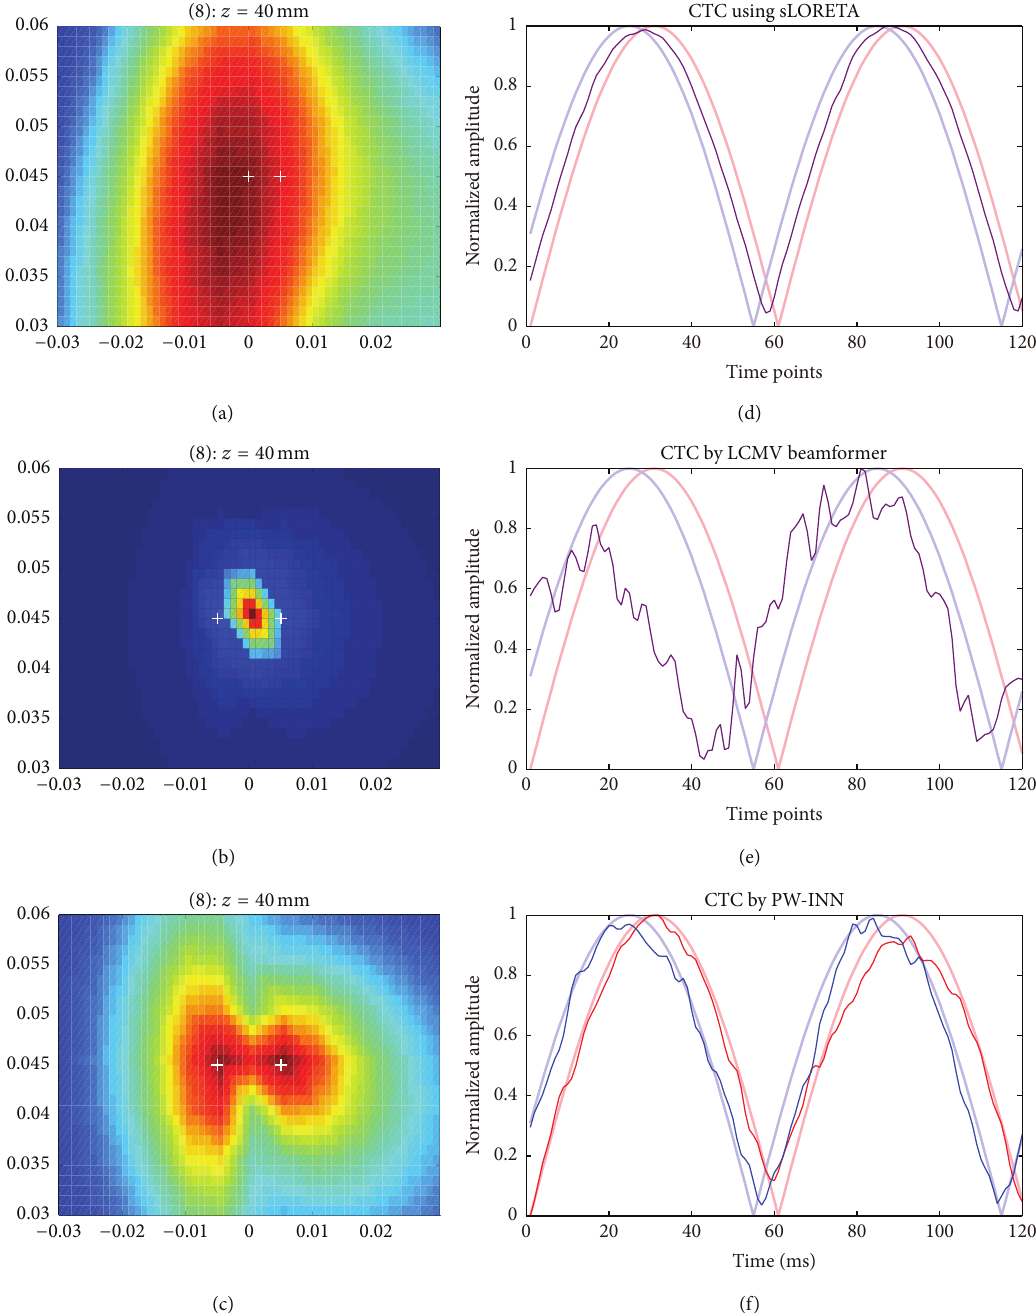
Figure 6: Source reconstruction using sLORETA, LCMV beamformer, and PW-INN. Source locations were the same as those in Figure 2. Real MEG noise was added such that SNR = 18. Two simulated source time courses have phase difference of 18 degrees. The correlation 𝑟 2 between sources is 0.95. (a)–(c) Source distribution estimated from sLORETA (a), LCMV beamformer (b), and PW-INN (c). White crosses indicate the true source locations. (d)–(f) Source time courses at the peak locations estimated from sLORETA (d), LCMV beamformer (e), and PW-INN (f). The time courses in (d)–(f) are the norm of the original time courses over 𝑥𝑦𝑧 -axis (i.e., collecting time courses, CTC). Bold lines in light red and light blue indicate the true source time courses and thin lines in red and blue indicate the estimated